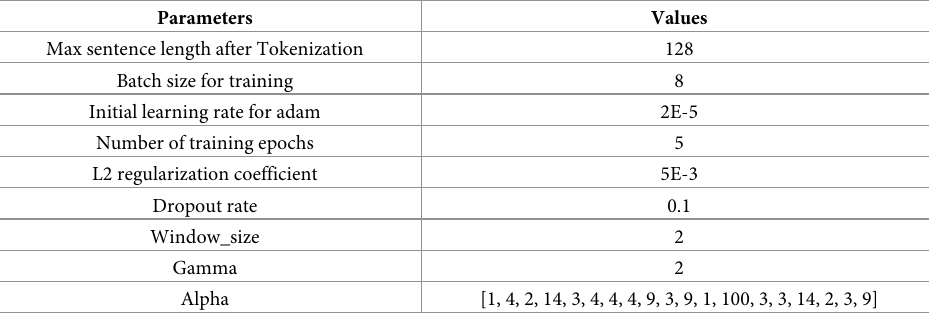
Table 5. The hyper-parameters of Bert for fine tune in SemEval-2010 Task-8